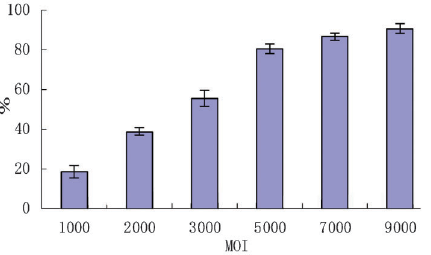
Figure 3. Infection efficiency of Ad-BMP2-bFGF in bone marrow progenitor cells. The infection efficiency was calculated by the number of green fluorescent protein-positive cells/total number of nuclei stained with DAPI x100 (%) (n=3). MOI: multiplicity of infection.